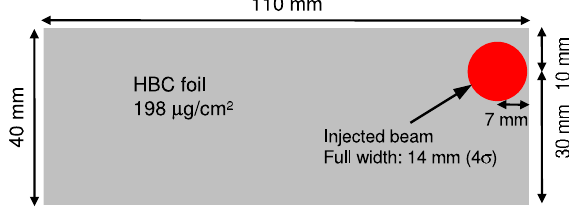
FIG. 10. The positioning of first generation primary stripper foil with respect to the injected beam for the RCS operation in run 33. Injected beam center to the foil edge was 7 mm in the horizontal direction, whereas the foil was with an offset of (cid:1) 10 mm in the vertical direction in order to reduce the beam loss due to the multiple Coulomb scattering of the circulating beam at the foil.